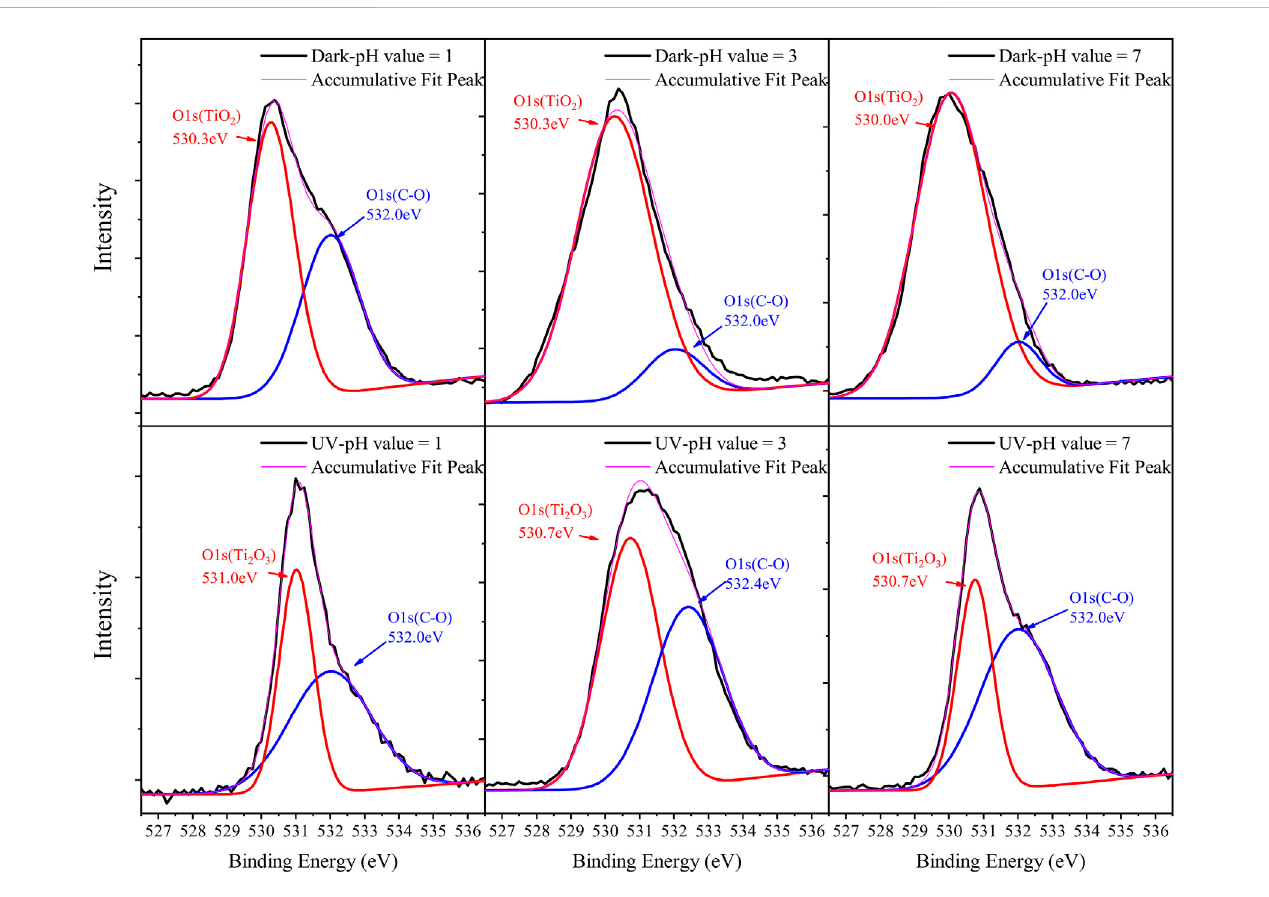
FIGURE 10 XPSresultsofO 1s ofwearscarsonTiO 2 surfacesafterrunning-inindifferentpHvalues(HiranoandShinjo,1990;Dienwiebeletal.,2005;Tianetal.,2022) with and without ultraviolet